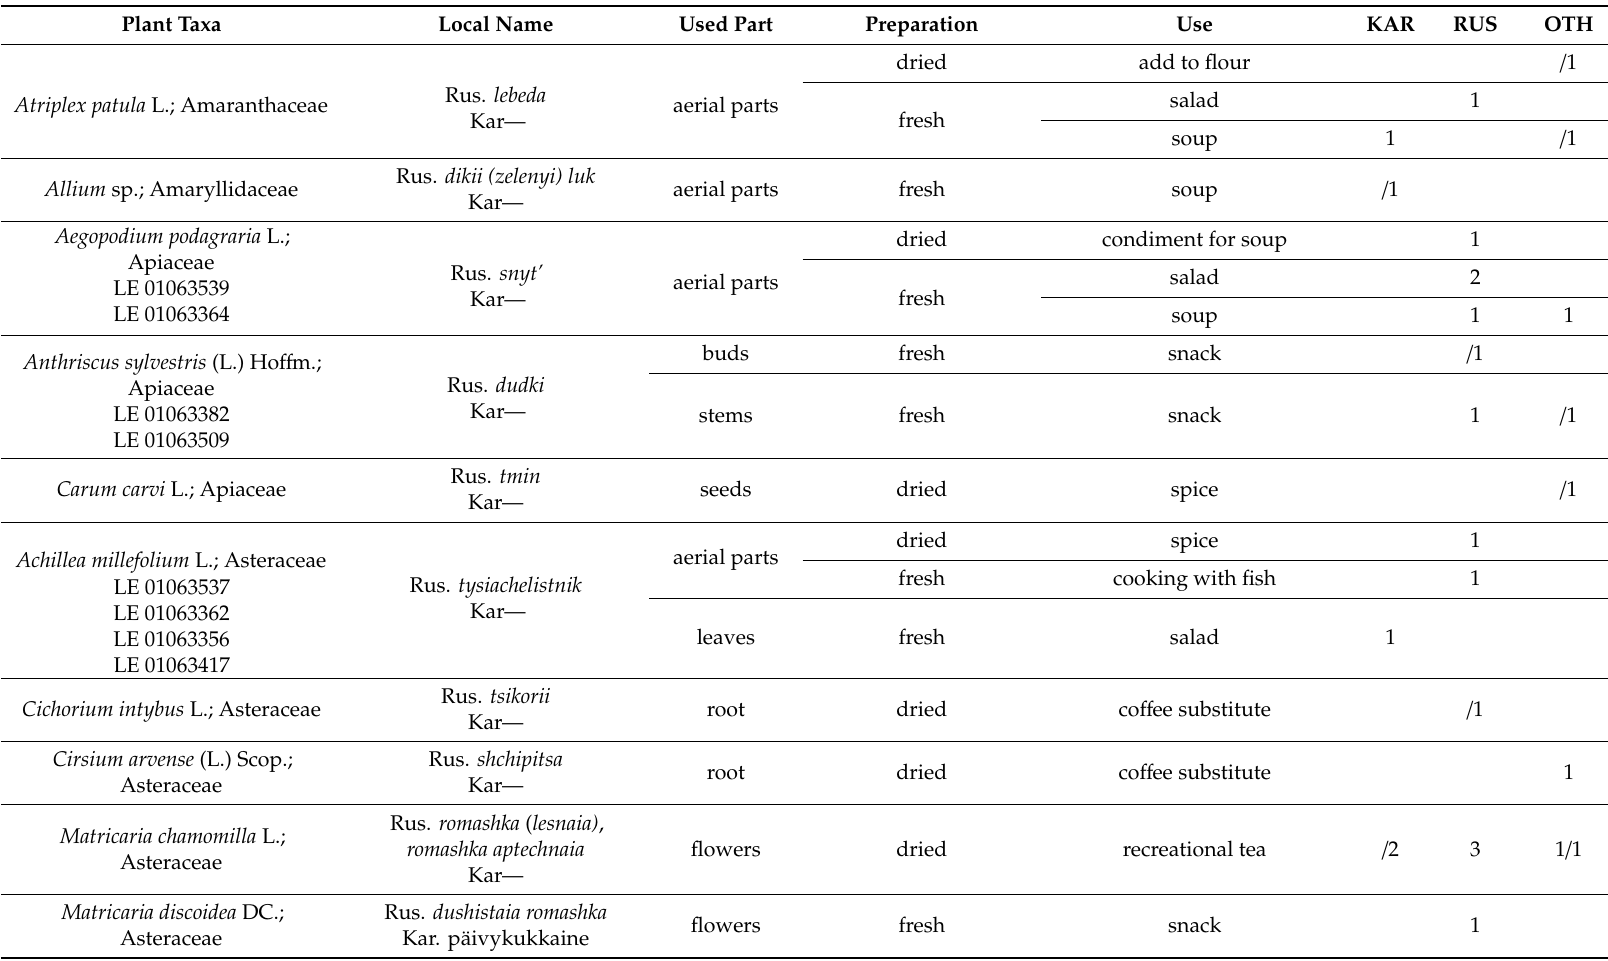
Table 2. Current / past uses of the wild food plants in Karelian